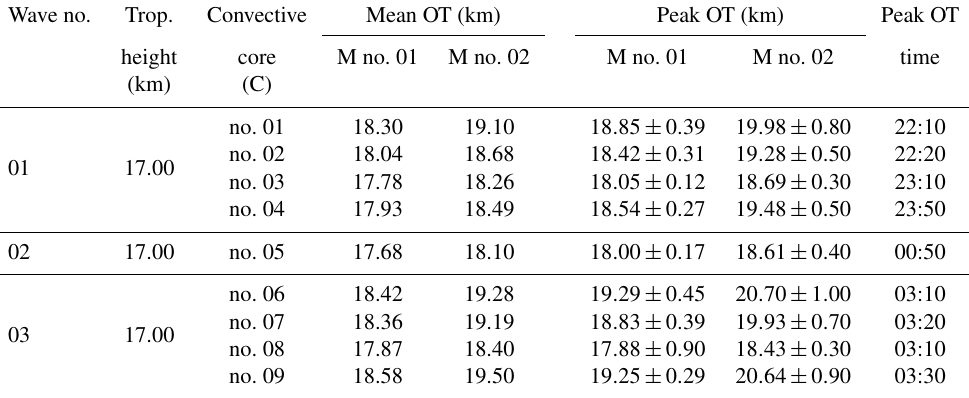
Table 2. Characteristics of overshooting tops (OTs) of the convective cores (Cs) during the 1–2 October 2019 CGW events. Wave no. Trop. Convective Mean OT (km) Peak OT (km) Peak OT height core M no. 01 M no. 02 M no. 01 M no. 02 time (km) (C) no. 01 01 17.00